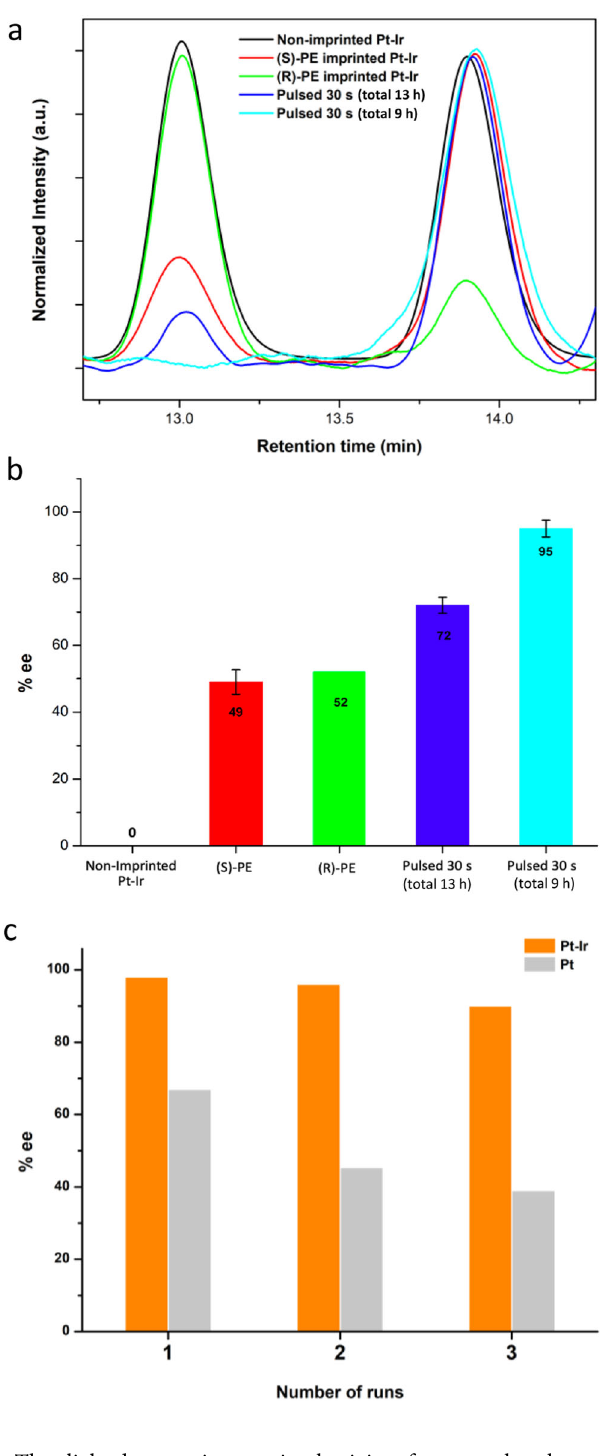
Fig. 5 Enantioselective electrosynthesis. Analysis of reaction products after asymmetric electroreduction of acetophenone on chiral-imprinted Pt- Ir alloy surfaces. a HPLC chromatograms of chiral products obtained with potentiostatic electrosynthesis for 13 h and pulsed potential synthesis (pulse time 30 s) in 1 M NH 4 Cl (pH 4.0) at − 0.35 V using the different Pt-Ir electrodes. b Histograms summarizing the enantiomeric excess (%ee) for non-imprinted Pt-Ir, (S)-PE (red), and (R)-PE (green) imprinted Pt-Ir electrodes, obtained by steady-state electrosynthesis, or (S)-PE-imprinted Pt-Ir electrodes used in pulsed electrosynthesis with a total pulse duration of 13 h (dark blue) and 9 h (light blue). c Comparative graph of the %ee obtained from reusability tests of a (S)-PE-imprinted Pt-Ir electrode (orange) and literature results obtained with a (S)-PE-imprinted monometallic Pt electrode 26 (gray). Retention times of (R)-PE and (S)-PE are 13.0 and 13.9 min, respectively. The s.e.m. is